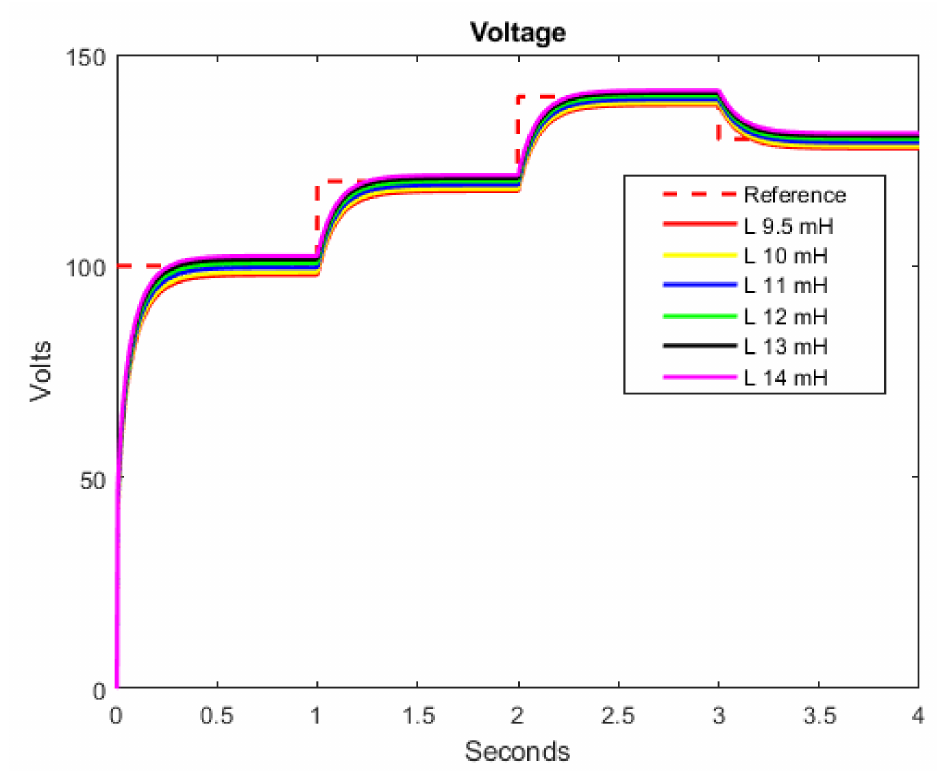
Figure 8. Output voltage of a boost converter under changes in reference voltage and inductance.